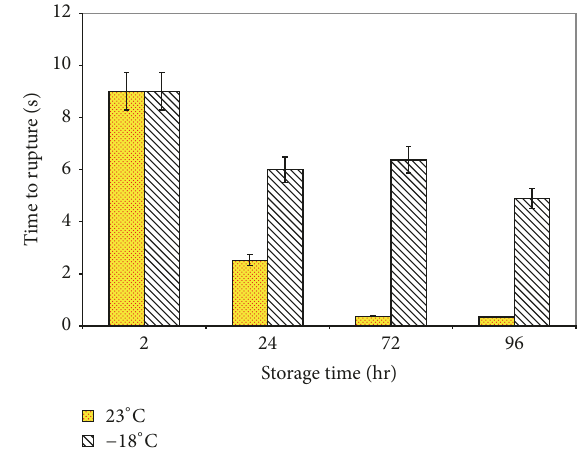
Figure 2: Relationship between time to rupture and storage time for PB at different storage